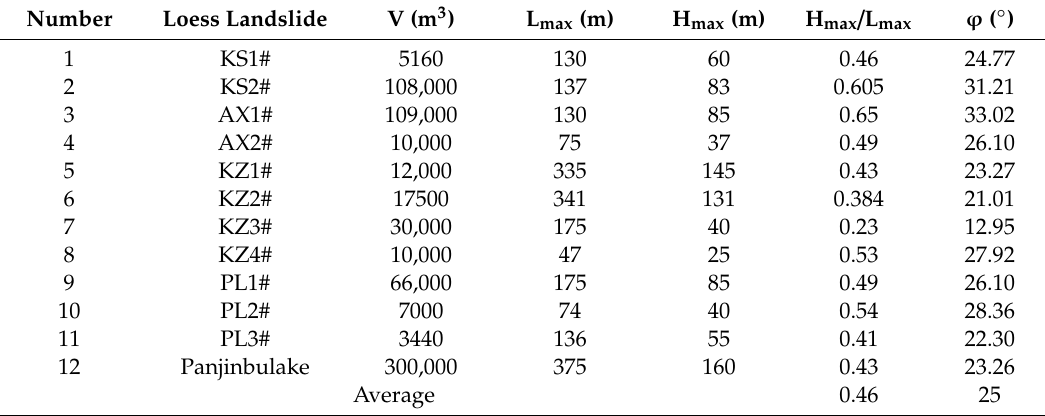
Table 3. Basic geometry of the loess landslides in the Piliqinghe